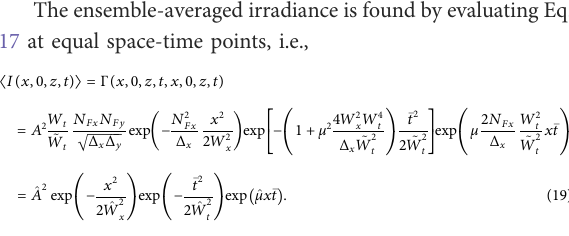
In order, the exponentials are the spatial beam shape, temporal beam (pulse) shape, and x - t plane rotation. The behavior of the ^ W ^ W ^ μ versus beam can be understood by examining x , t , and Fresnel number and turbulence strength. Figure 1 shows these ^ W ^ W ^ μ / μ over Fresnel numbers curves: (A) plots x / W x , t / W t , and ranging from 100 (near fi eld) to 0.01 (far fi eld). The solid, dashed, dashed-dotted, and dotted traces show how these quantities evolve in free space ( C 2 n (cid:1) 0m − 2/3 ) and atmospheric turbulence ( C 2 n (cid:1) 10 − 14 m − 2/3 with L 0 = 10 m, 50 m,